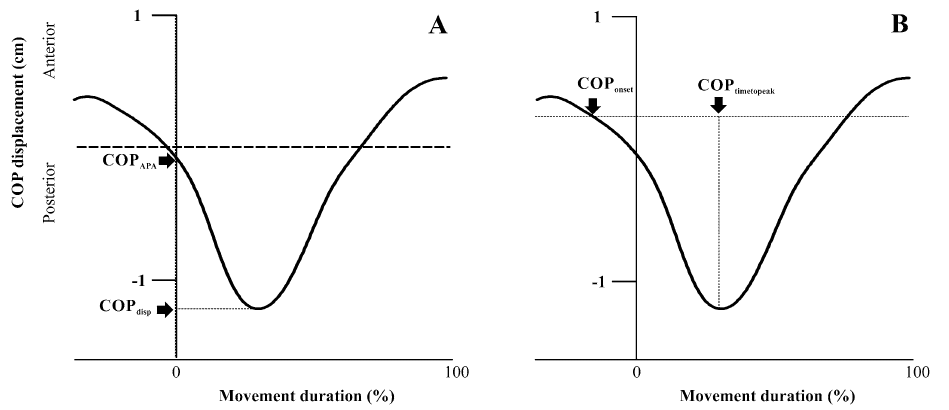
Figure 3. ( A , B ) Anteroposterior COP displacement (y-axis) when a participant moves his/her arm. Dashed line represents movement onset. Four variables: (1) COP APA , amplitude of backward COP displacement at T 0 ; (2) COPdisp, maximum backward displacement after T 0; ( A ); (3) COPonset, time of initial backward displacement before T 0 ; and (4) COPtimetopeak, time to reach maximum displacement ( B ).